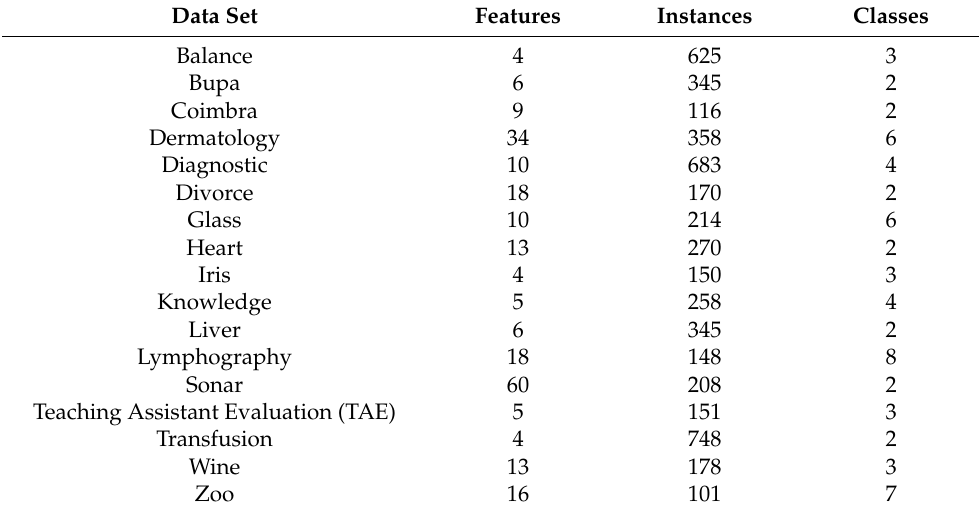
Table 1. List of data sets.